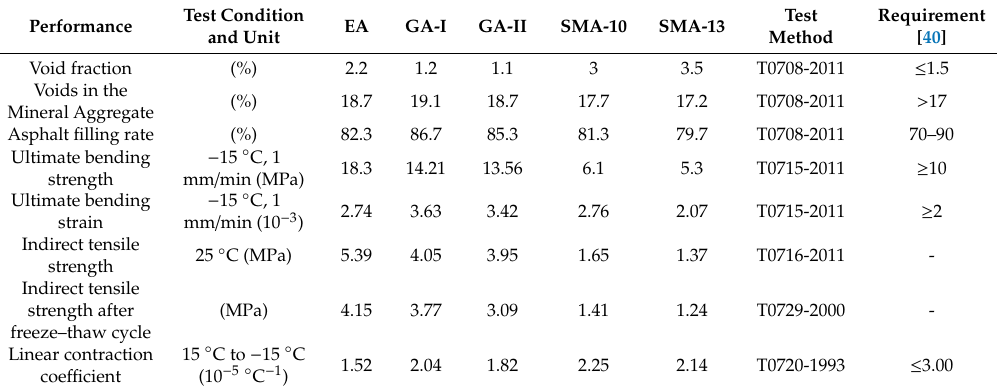
Table 2. Pavement performance of asphalt